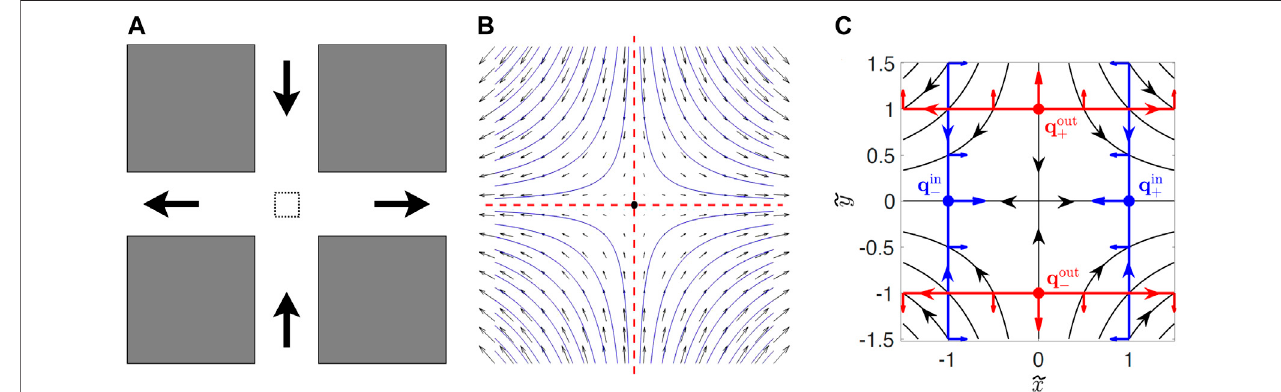
FIGURE1|(A) SketchofthePDMScross-channelcell.Fluidispumpedinatthetopandbottomandpumpedoutattheleftandright.Thedashedboxinthemiddle of the intersection is the region where the fl ow is approximately hyperbolic. (B) Zoom in of fl ow in the dashed box in (A) . The vertical (horizontal) red dashed line is the stable (unstable) passive manifold of the passive fi xed point (dot at center). (C) Diagram showing swimming fi xed points q in and q out , and swimming invariant manifolds (SwIMedges)inredandblue(fromRef.[34]).TheredandbluearrowsperpendiculartotheSwIMedgesin (C) showtheswimmingdirectionthatisblockedbythese structures.